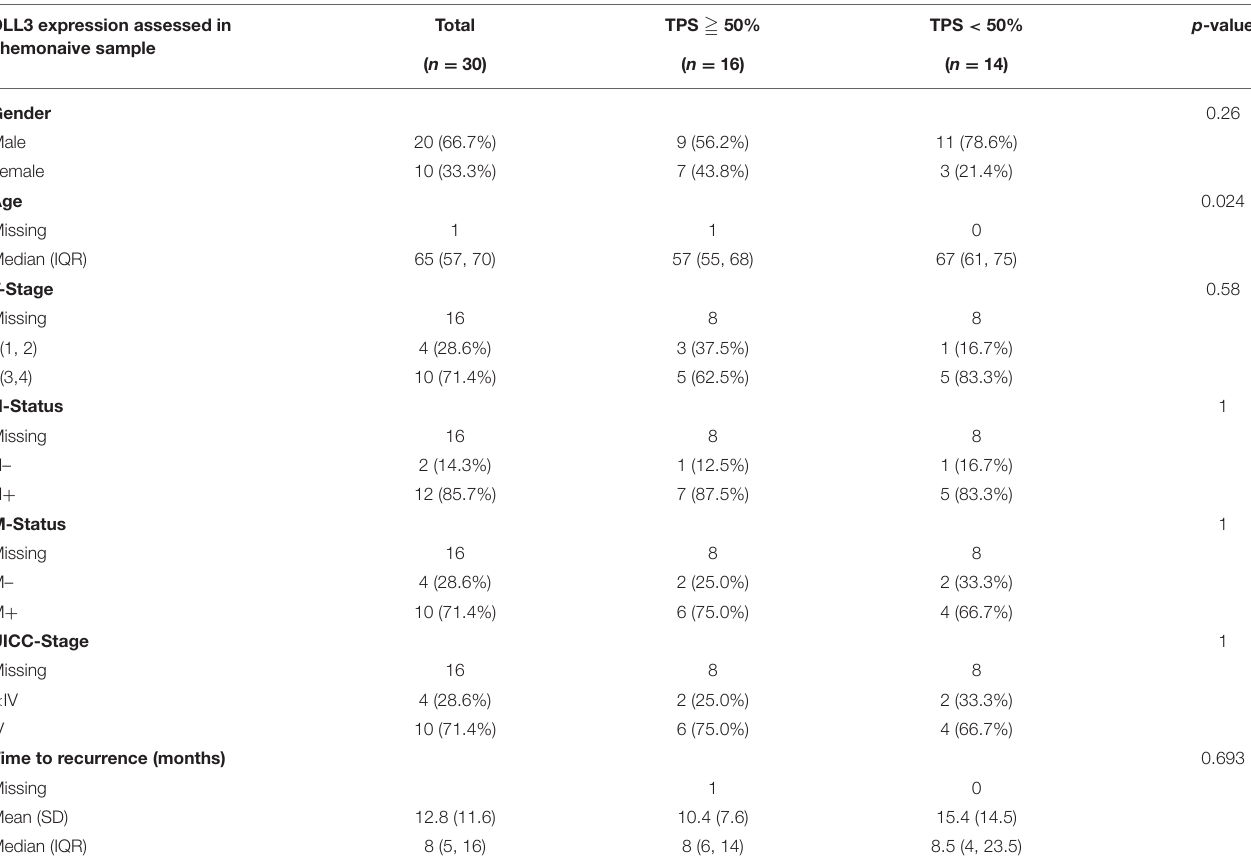
TABLE 2 | Association analysis between DLL3 expression assessed in chemonaive samples and clinicopathological characteristics of paired chemonaive-chemorelapsed SCLC cohort. DLL3 expression assessed in chemonaive